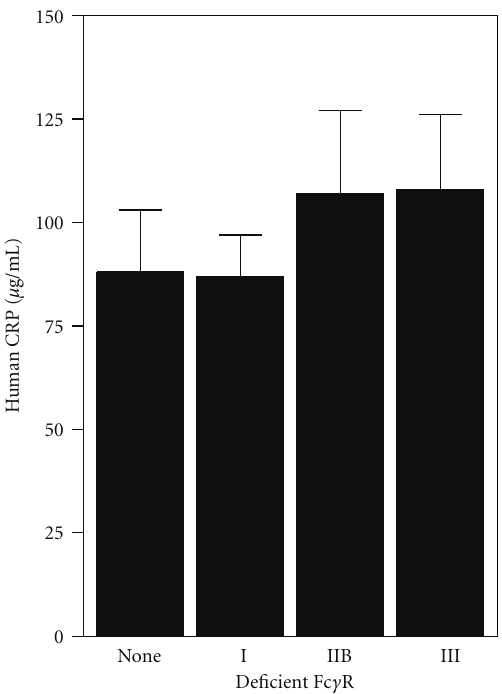
Figure 1: No e ff ect of Fc γ R deficiencies on expression of human CRP by CRPtg mice. Each bar and each whisker are the mean and standard deviation, respectively, for human CRP serum concentration measured for n = 5 mice. Blood was obtained 24 hours after i.p. injection of 25 μ g endotoxin, and human CRP was measured by ELISA, both as described in